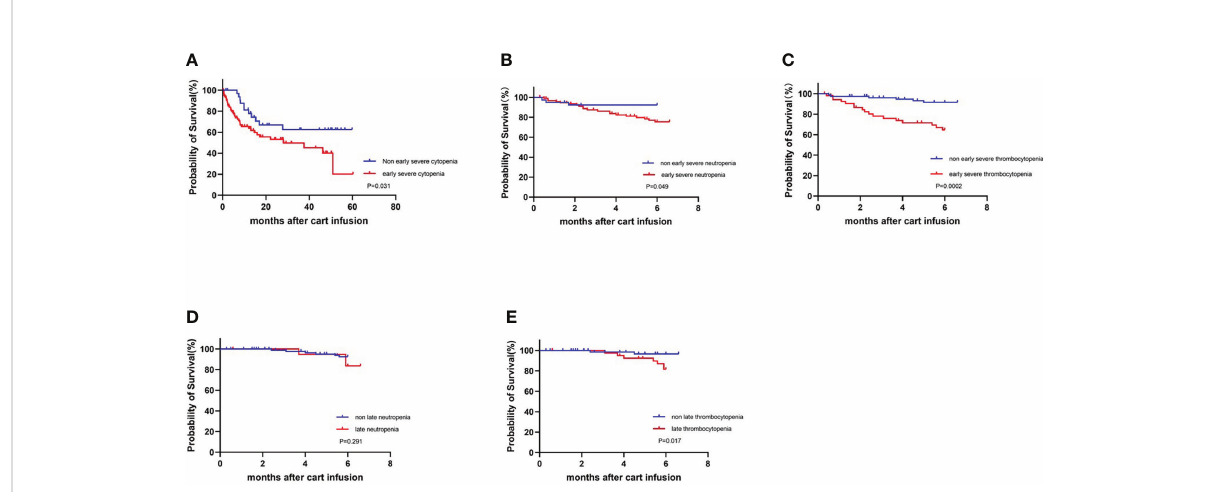
FIGURE 5 Survival curves for all patients who underwent infusion of CART cell with or without severe cytopenia. KM estimates of OS (A) in patients with non-severe cytopenia (blue) and with severe cytopenia (red). (B, C) Early severe neutropenia and thrombocytopenia compared with non- occurring group at 6-month survival. (D, E) Late neutropenia and thrombocytopenia compared with non-occurring group at 6-month